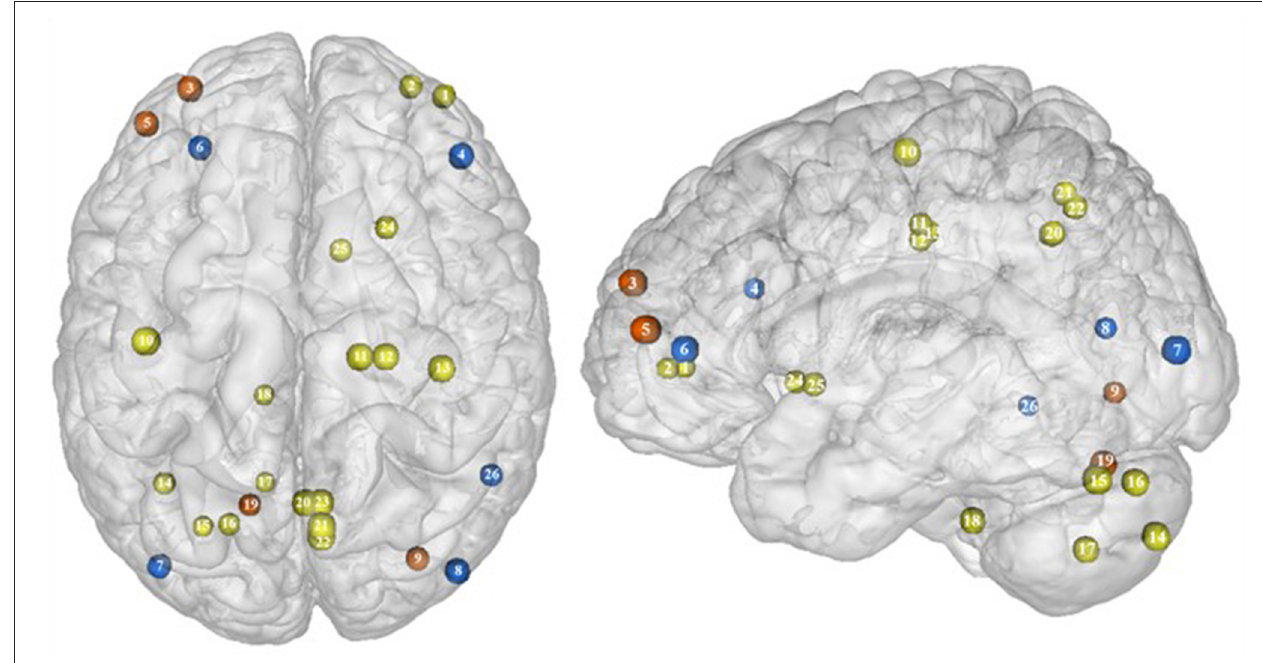
FIGURE 7 | Functional activity in individuals with binge eating disorder during inhibition. Blue color indicates hypoactivity in obese individuals with binge eating disorder in comparison with obese individuals without binge eating disorder during inhibition. Yellow and orange colors indicate hypo- and hyperactivity, respectively, in lean with binge eating disorder in comparison with lean without binge eating disorder (see Table 6 for precise coordinates). 1–2 = ventromedial prefrontal cortex (51), 3 = dorsomedial prefrontal prefrontal cortex (51), 4 = dorsolateral prefrontal cortex (47), 5 = dorsolateral prefrontal cortex (51), 6 = ventrolateral prefrontal cortex (44), 7–8 = visual cortex (44), 9 = visual cortex (51), 10 = primary motor cortex (51), 11–12 = premotor cortex (51), 13 = primary sensory motor cortex (51), 14–19 = cerebellum (51), 20–23 = precuneus (51), 24–25 = putamen (51), 26 = temporal gyrus (44).